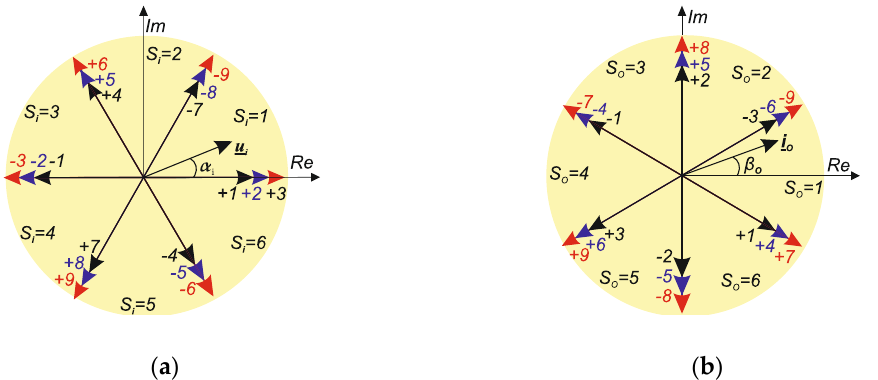
Figure 4. Graphic interpretation of active vectors: ( a ) input voltage at converter; ( b ) output current.